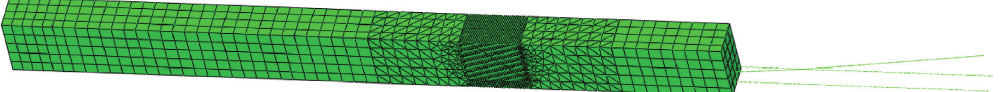
Figure 8: Discretization of the finite element